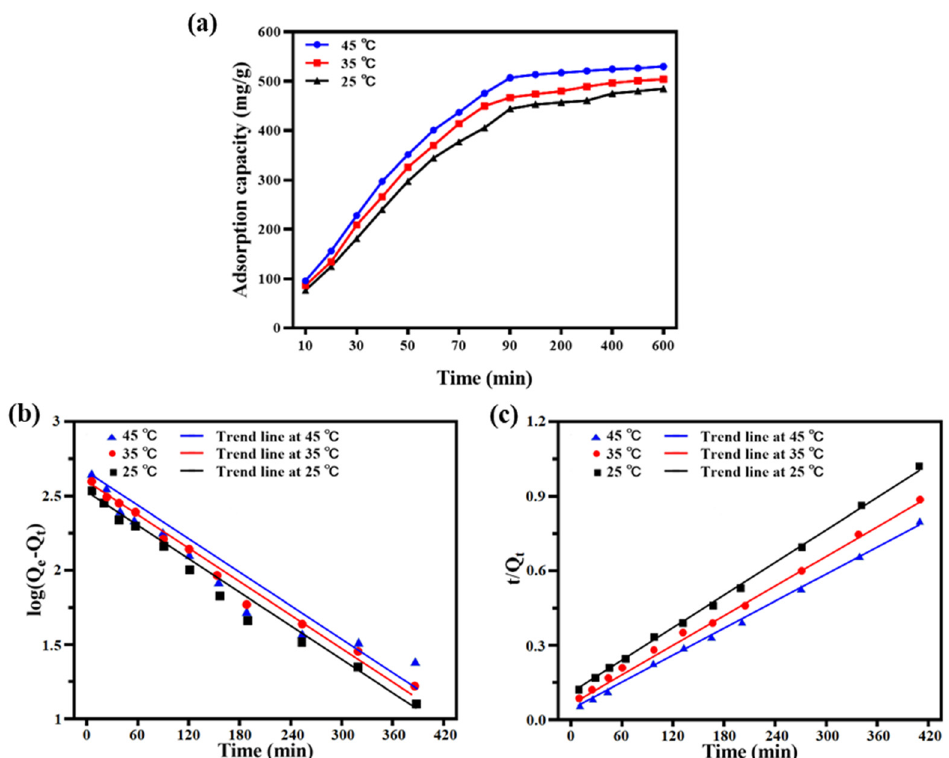
Figure 4. The adsorption kinetics curve of the adsorption process of EGCG by PILs. ( a ): Three typical temperatures (25 °C, 35 °C and 45 °C) were investigated to explore the adsorption kinetics. The fitted plots of the pseudo-first-order ( b ) and pseudo-second-order ( c ) kinetic models are based on the adsorption capacity–temperature results. Table 3. Parameters in the pseudo-first-order and pseudo-second-order kinetic models.